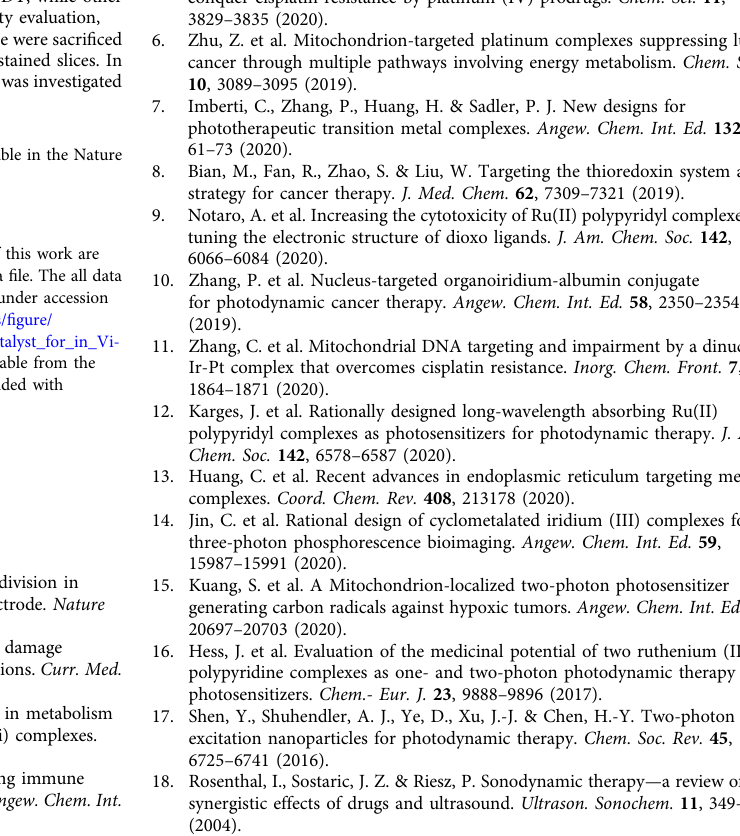
side of mice, and the US probe was on the left side of mice during treatment. The US waves penetrated from left side of mice to right side during SDT, while other experimental details remain unchanged as before. For the biosafety evaluation, healthy mice were i.v. injected with 2.5mg kg − 1 [Ru(bpy) 3 ] 2 + . Mice were sacri fi ced